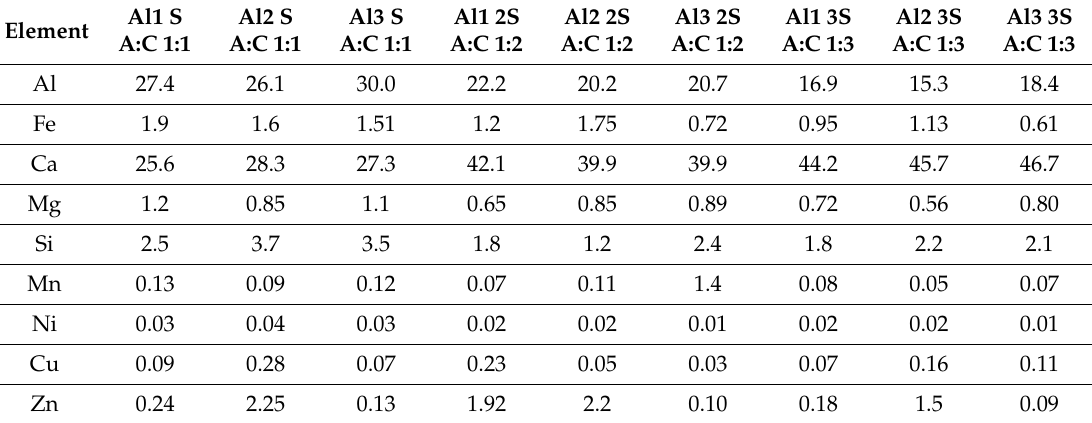
Table 3. Average chemical composition (number of samples = 5) of the sintered materials (wt %), (A = Al 2 O 3 and C = CaO).